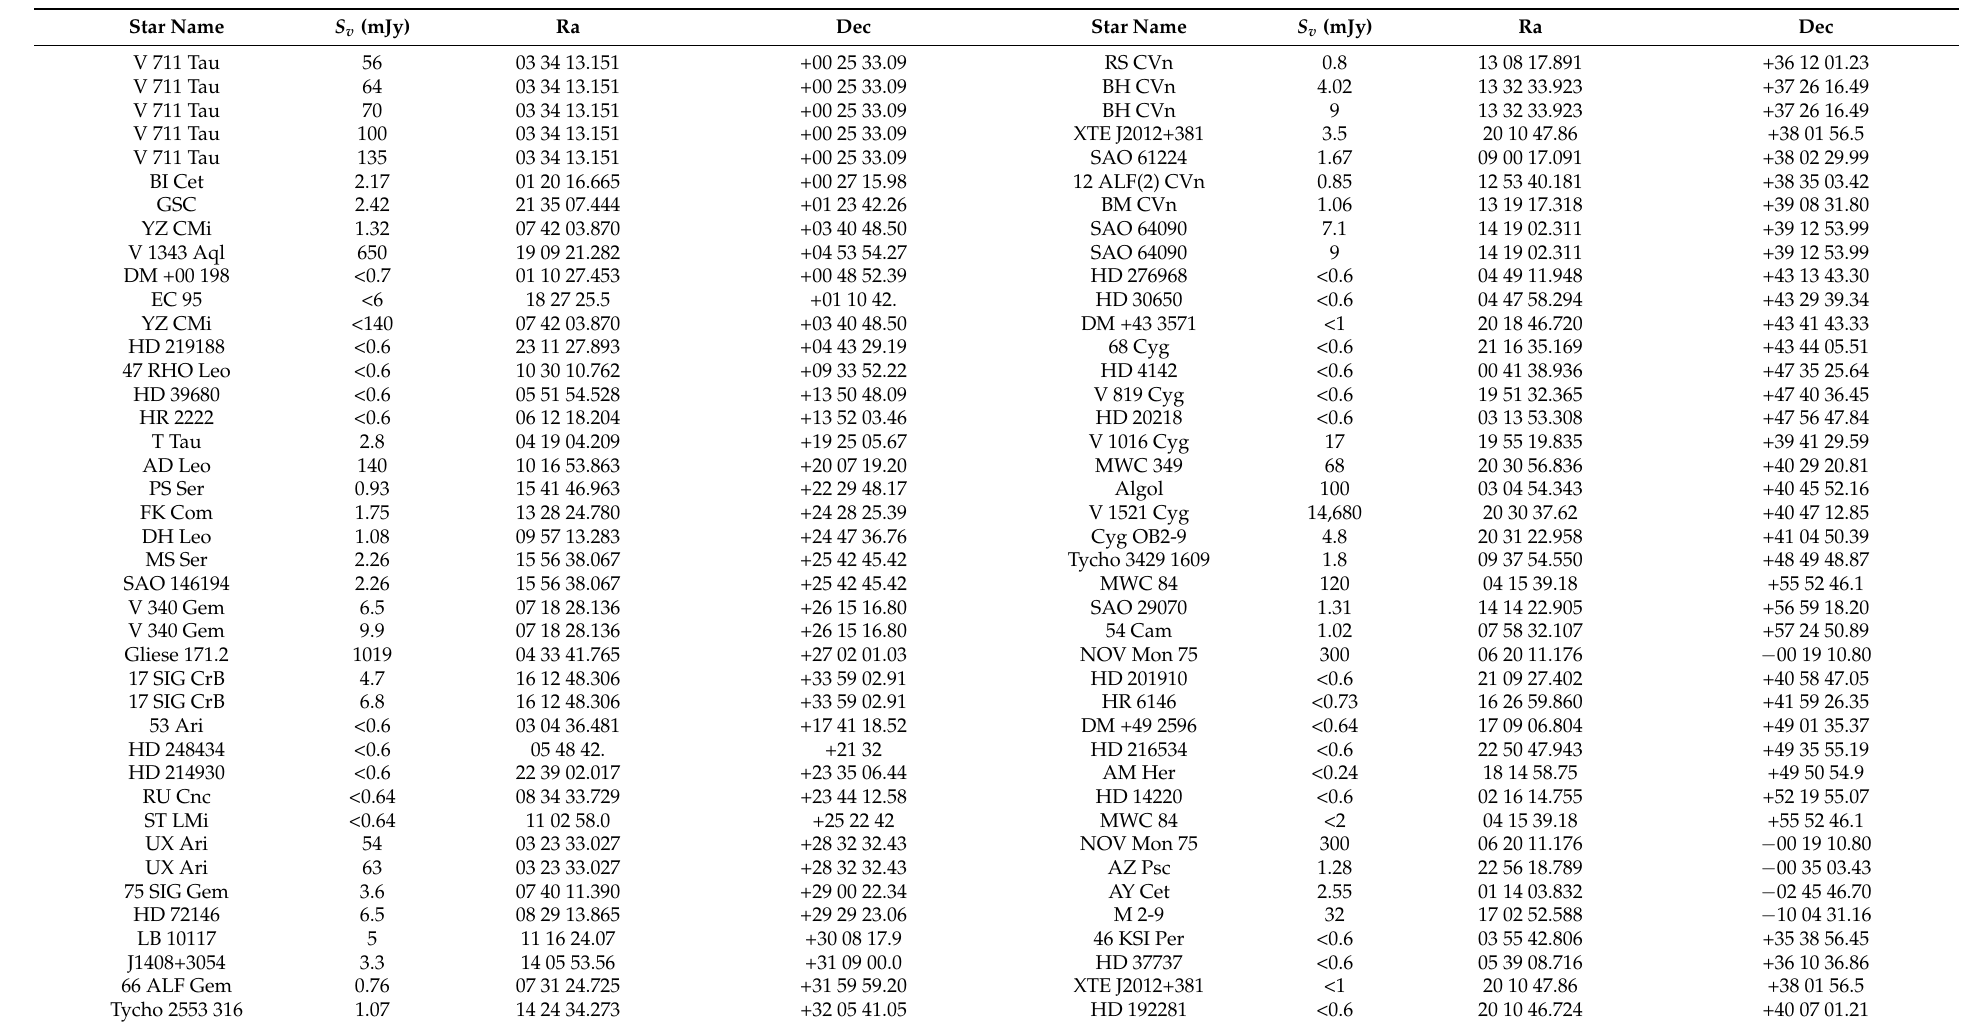
Table 4. Radio stars expected to be observed by FAST in the 1.4 GHz